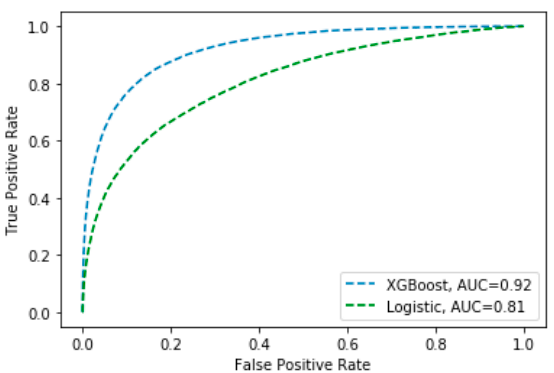
Figure A3. Similar to Figure 5, but for the models which do not include wildfire history variables.